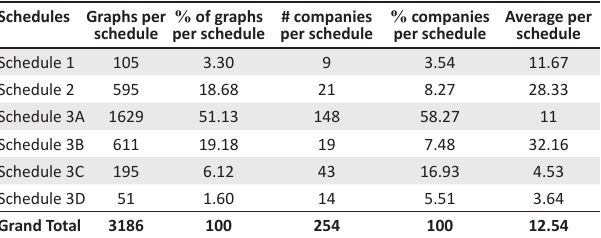
TABLE 4: Schedule analysis of graph